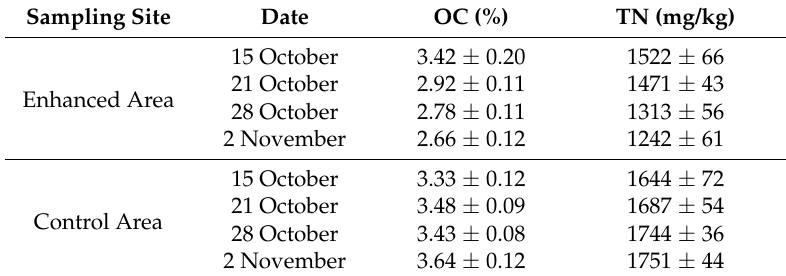
Table 1. Changes in OC and TN concentrations in the surface sediment (0–1 cm) at the enhanced and control areas during the operation of WLAs, in